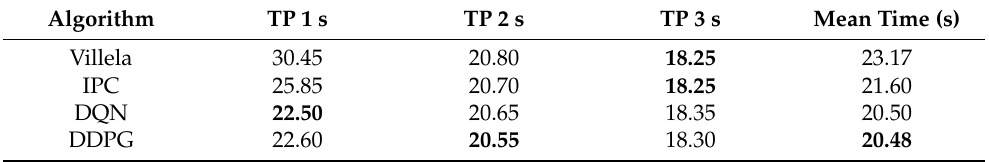
Table 6. Arrival time for the three target points for the experiment without obstacles.